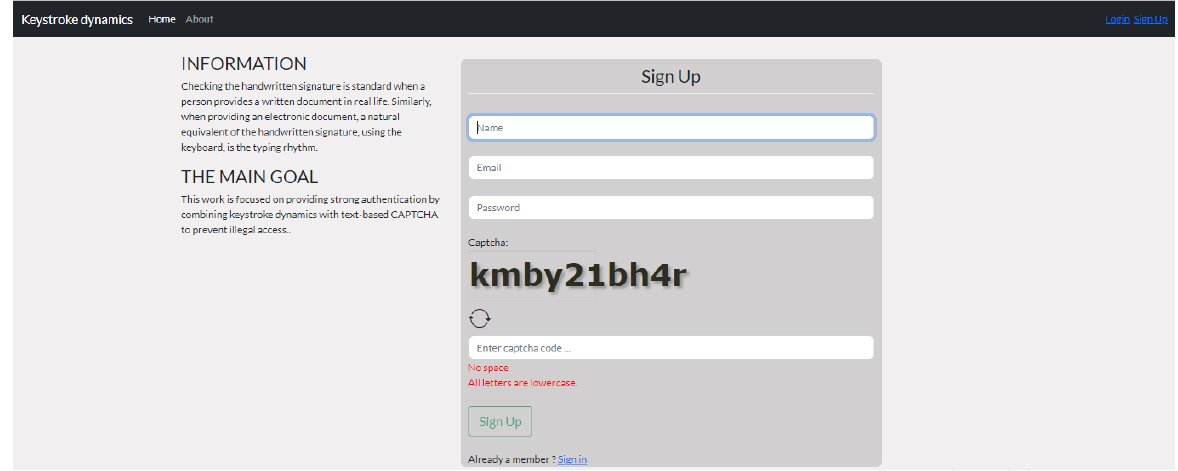
Figure 5. Sign-up page.